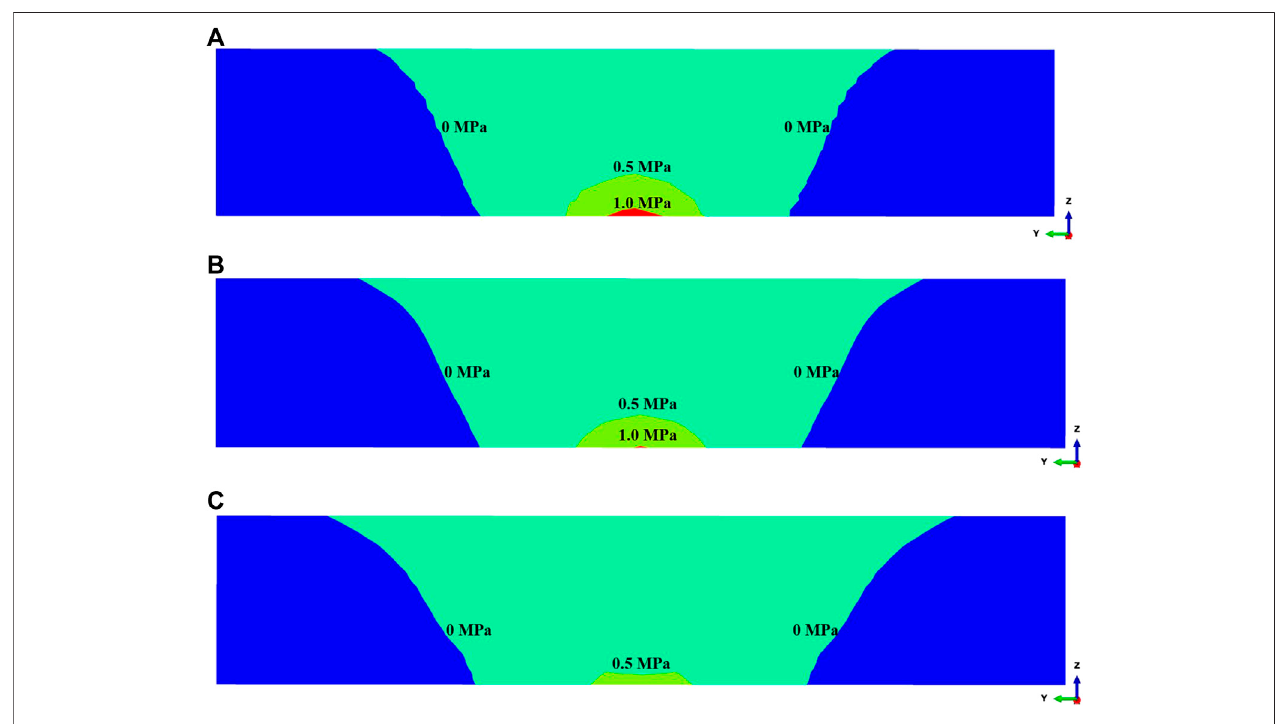
FIGURE 4 | Contour lines of the maximum induced stress in pay zone 2 at different coordinates. (A) x = 0.0 m; (B) x = 20.0 m; (C) x = 40.0 m.